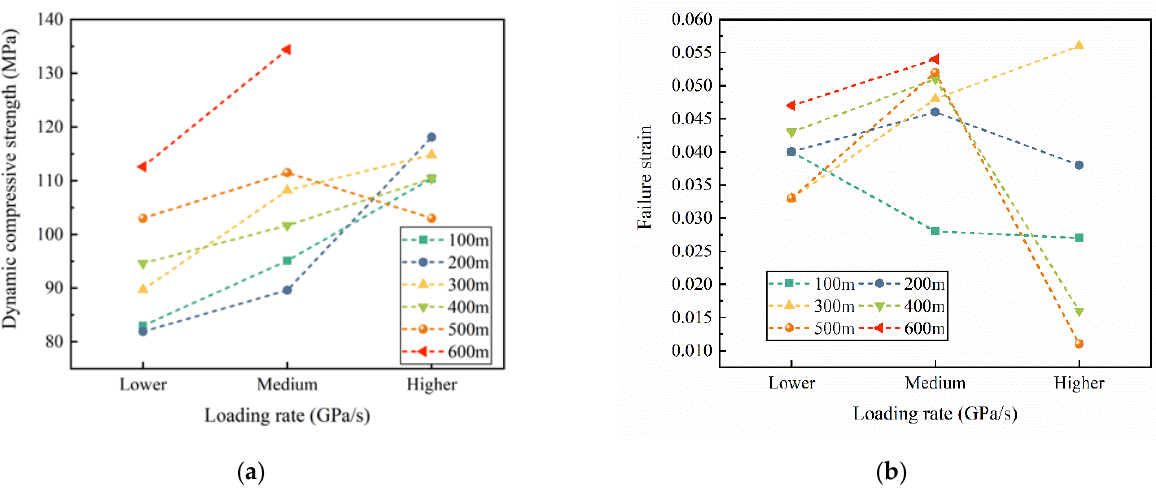
Figure 8. Relationship between dynamic compression strength, failure strain, and loading rate: ( a ) Relationship between dynamic compressive strength and loading rate; ( b ) Relationship between specimen failure strain and loading rate.